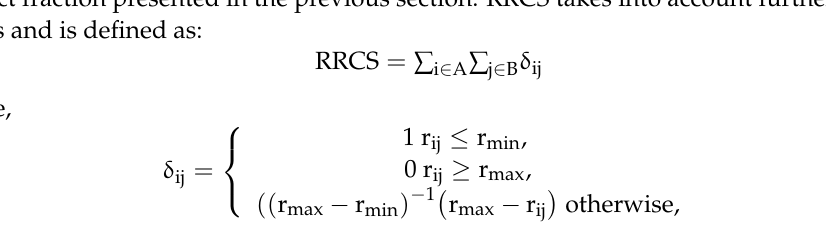
Table 1. Parametrization of global effects of ligands on averaged contact fractions.